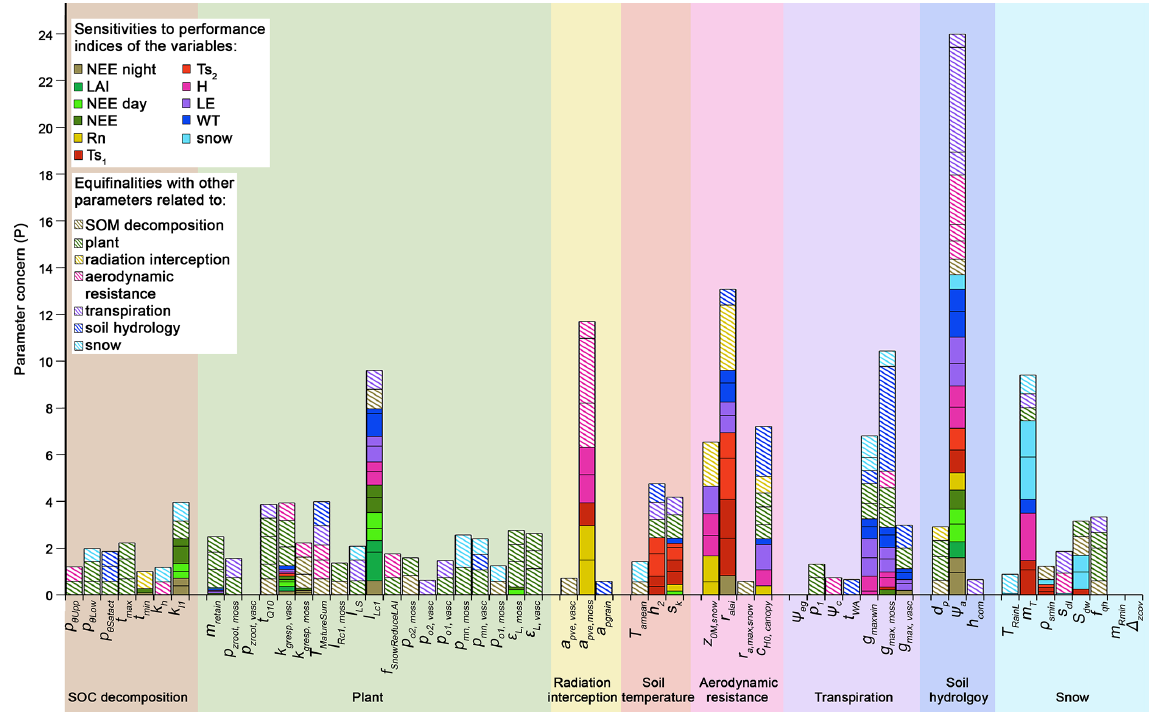
Figure 2. Parameter concern is shown on the y axis as sum of equifinalities (hatched) and sensitivities that could not be constrained unam- biguously (solid). The x axis shows the parameters that belong to the process category of the background colour.